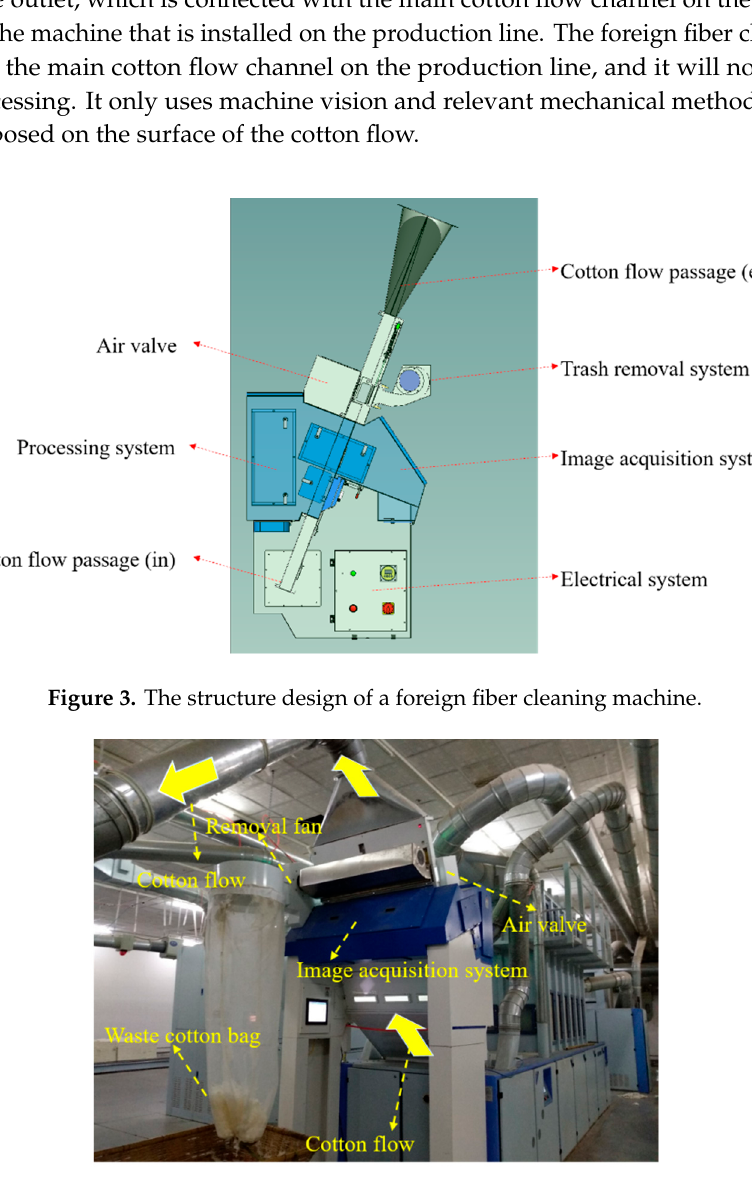
Figure 4. The foreign fiber cleaning machine installed on the production line.